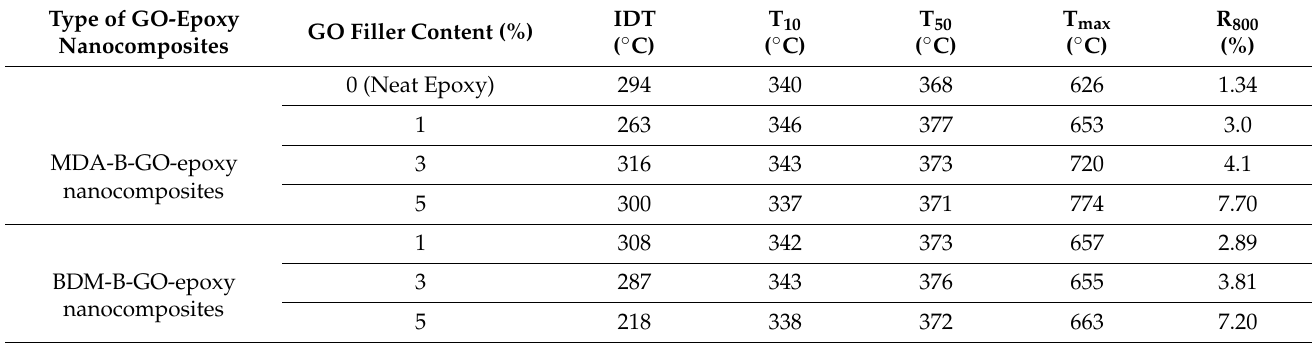
Table 5. TGA data of neat epoxy and MDA-B-GO/ BDM-B-GO-epoxy